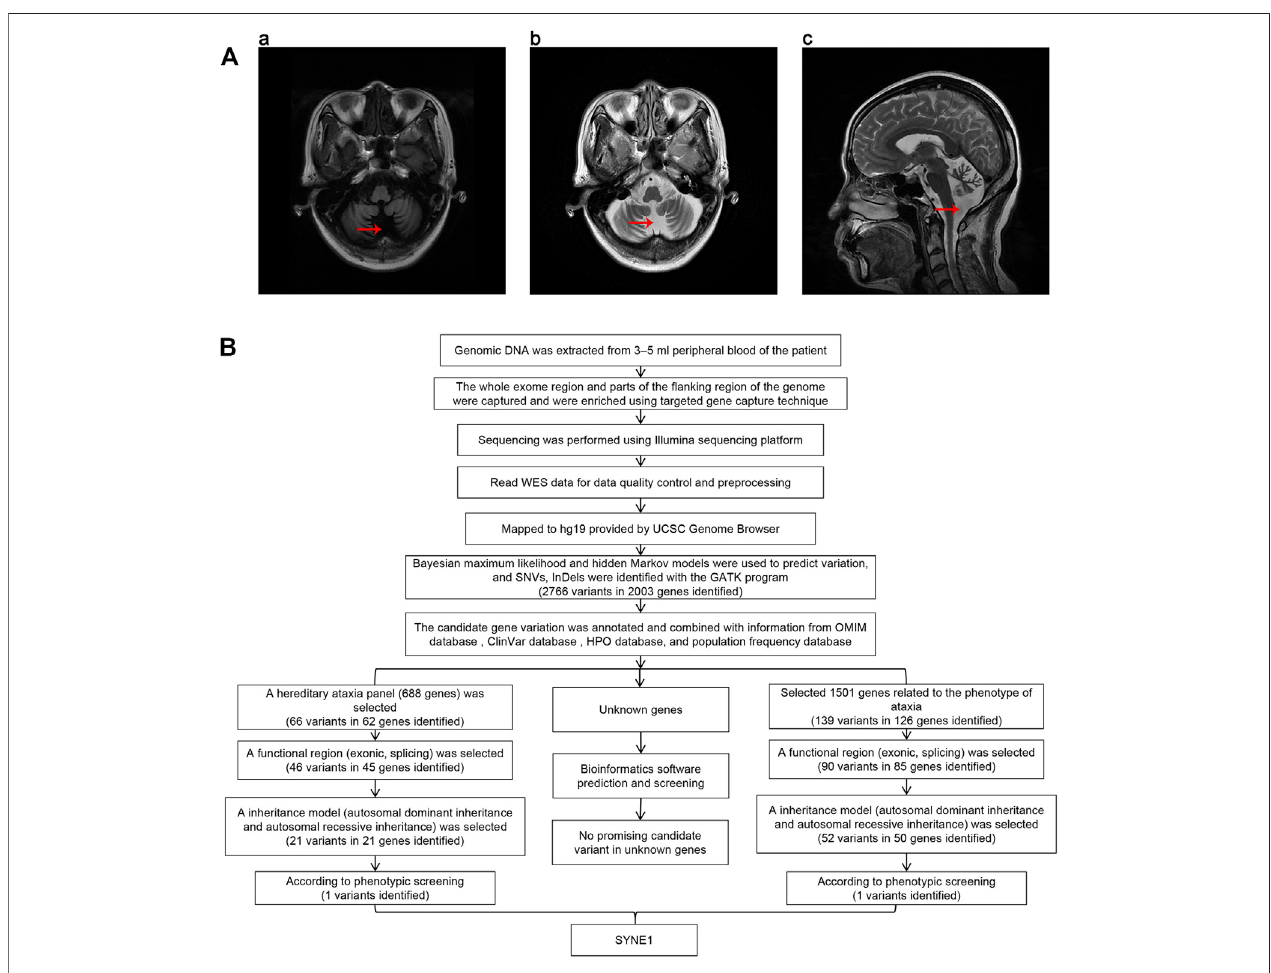
FIGURE1|(A) BrainMRIofproband.Theredarrowsinthechartsof “ a, ”“ b, ” and “ c ” showthatthesulcusinbothcerebellarhemispheresissigni fi cantlyincreased and widened, indicating cerebellar atrophy. (B) The work fl ow of analysis of whole exome sequencing